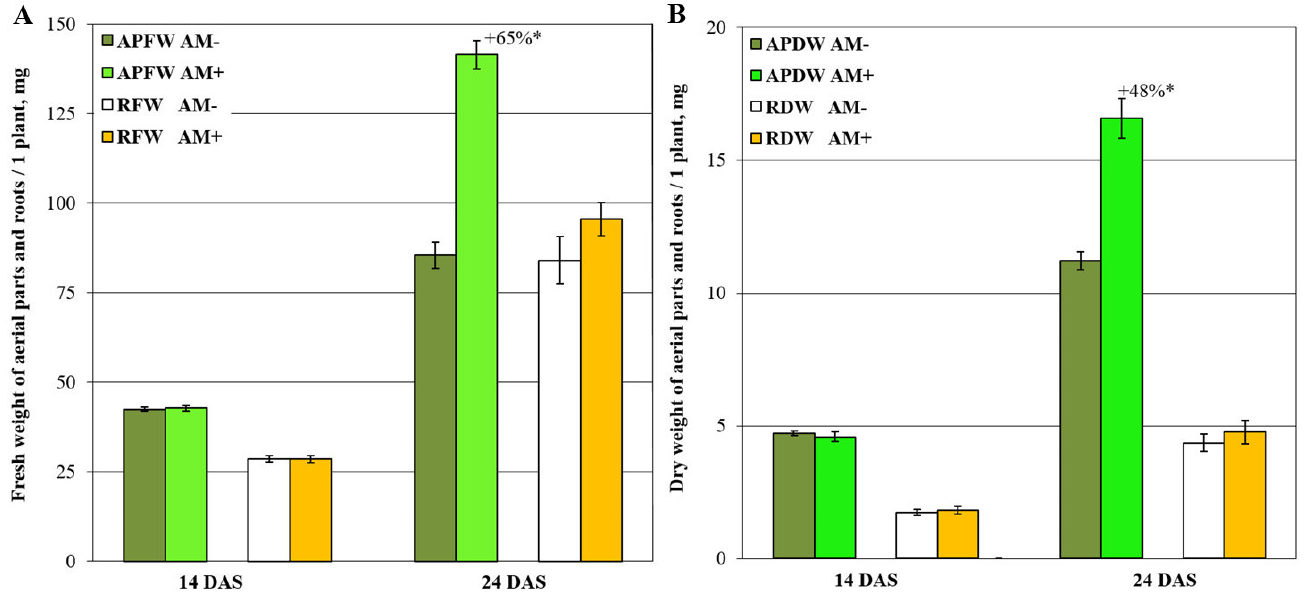
Figure 1. Fresh ( A ) and dry ( B ) weight of aerial parts and roots per one M. lupulina plant. “APFW” and “RFW” refer to fresh weight of aerial parts and roots, respectively. “APDW” and “DFW” are the dry weights of aerial parts and roots. “AM − ” and “AM+” are the variants without and with AM fungus inoculation. “+65%*” and “+48%*” are significant ( p < 0.05) mycorrhizal growth response (MGR, AM efficiency) within the same parameter of productivity (ANOVA and Tukey’s test; p < 0.05). “DAS” is the day after sowing and inoculation.